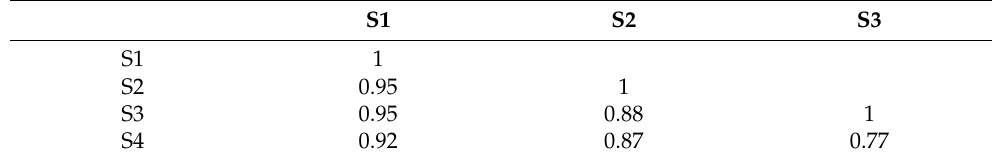
Table 4. Correlation coefficients for utility scores,